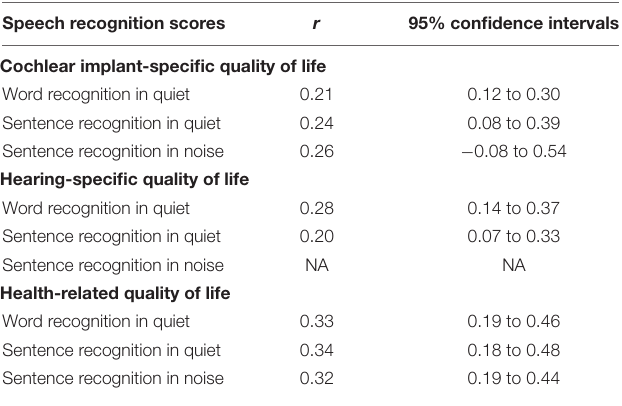
TABLE 1 | Meta-analysis of correlations between speech recognition scores and patient self-reported functional ability. Speech recognition